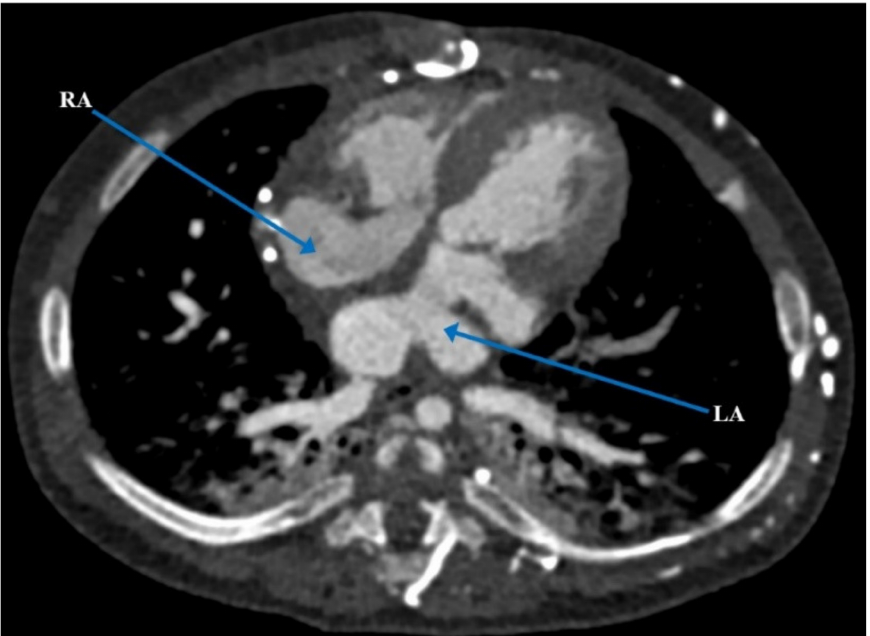
Figure 5. Post-operative computerized tomography demonstrating septation between the left and right atrium. LA = left atrium; RA = right atrium.